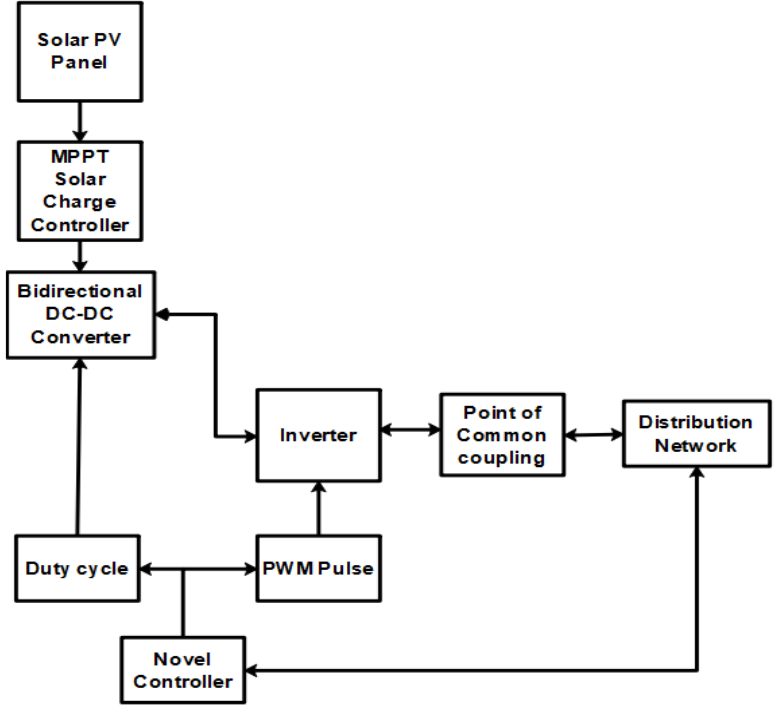
Figure 3. Process of PV-to-Grid.